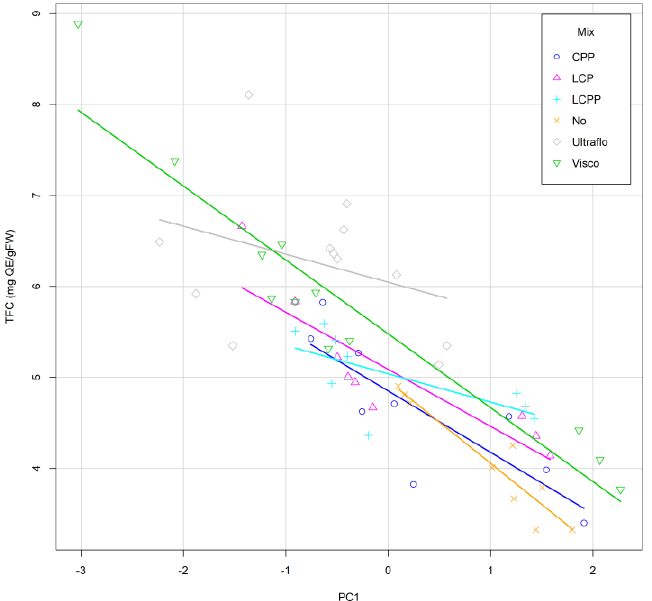
Figure 7. The total flavonoid content (mg QE/g FW) variability explained the 93.79% by the first principal component, PC1, related to the enzymatic cocktail (78.31%) and other factors level (21.69%). Lines represent linear regression of data dispersion within each enzymatic treatment. In order, two commercial cocktails: Ultraflo© (Ultraflo) and Viscozyme© (Visco); three formulated cocktails with laccase, cellulase, and pectinase at proportions of 1:1:1 (LCP), 1:1:2 (LCPP), and 0:1:2 (CPP); and the control without added enzymes (No).